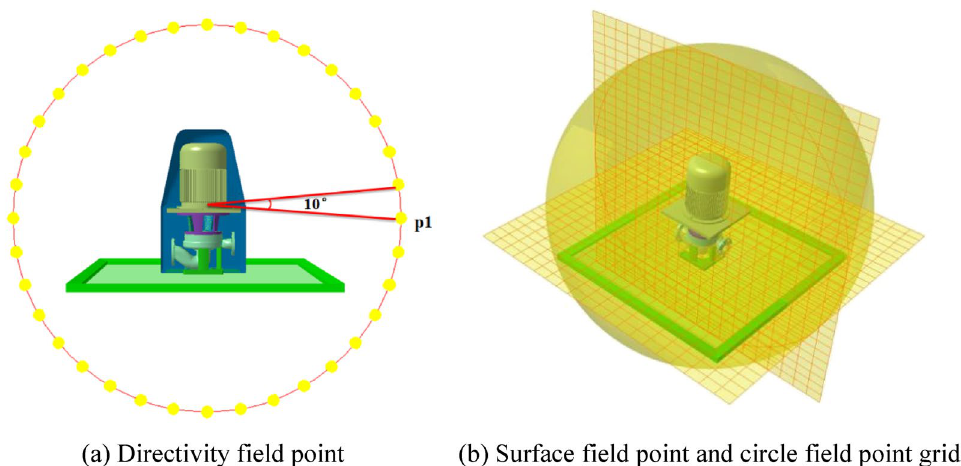
Figure 13. External sound field grid.